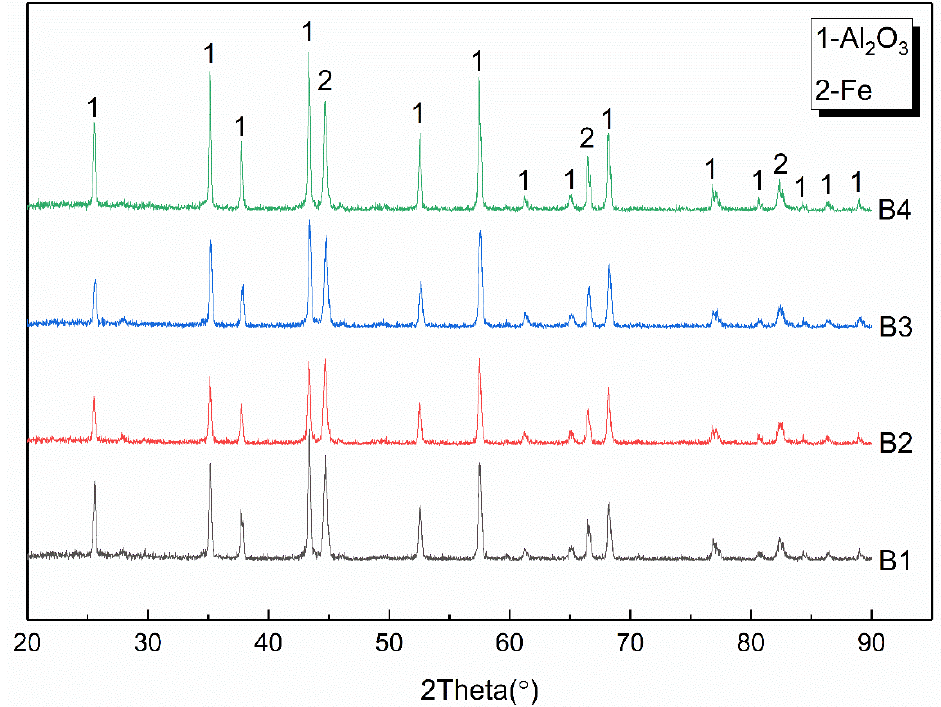
Figure 3. X-ray di ff raction patterns of the samples Figure 3. X-ray diffraction patterns of the samples B1–B4.